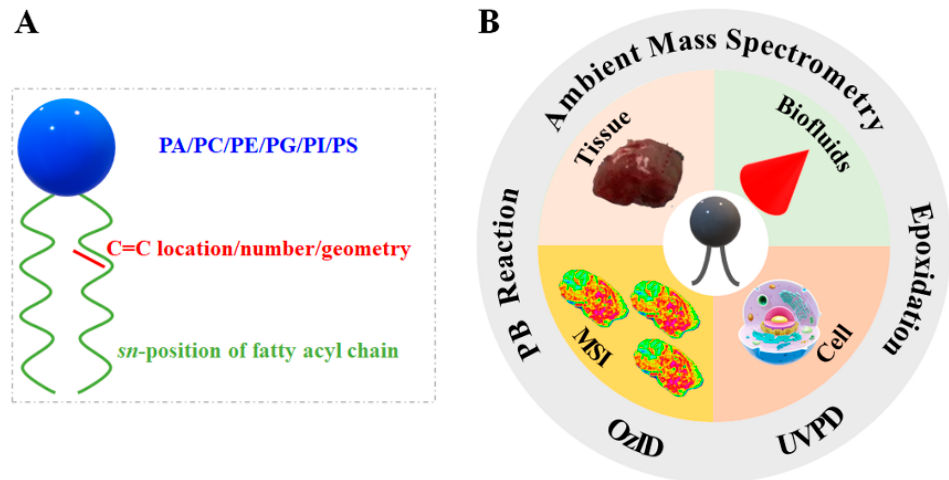
Figure 1. ( A ) The schematic figure indicates the chemical structure diversity and complexity of un- saturated lipids; ( B ) representation of different derivatization strategies coupling of AIMS techniques (outer ring) and examples of their applications (central pie chart).